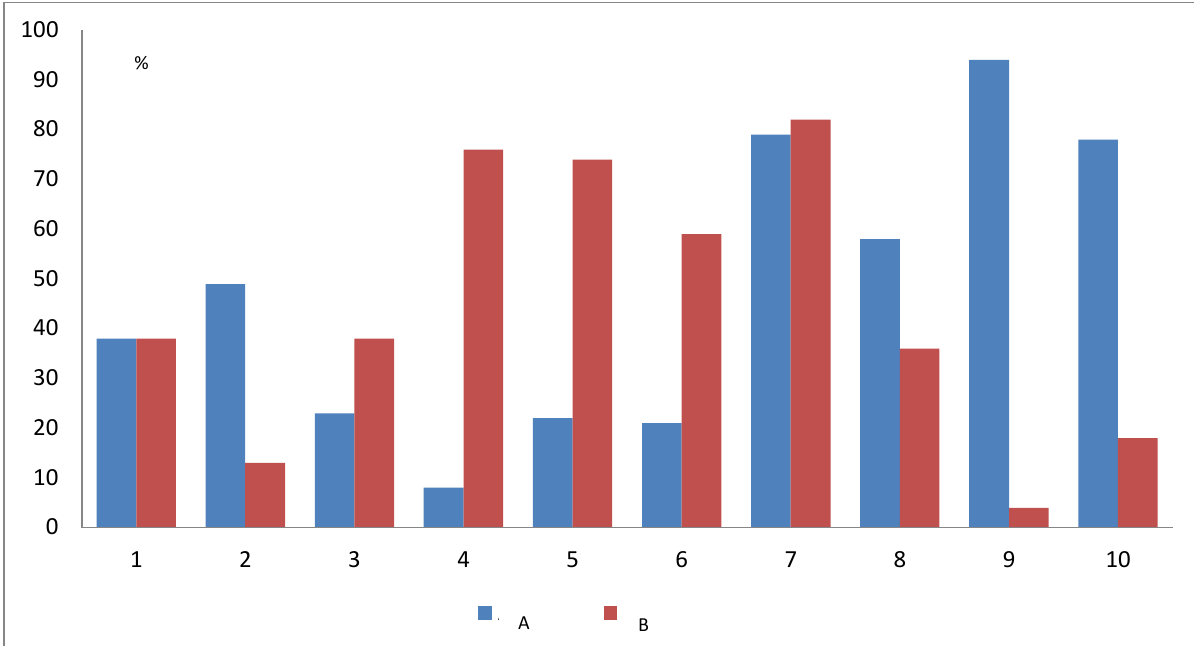
Fig.3. Time, spent by respondents for different kinds of activity: 1 – watching TV; 2 – reading; 3 –hobby; 4 – visiting of relatives; 5 – visiting of friends; 6 – cultural measures; 7 – volunteer organization and control of physical trainings; 8 – religious communities; 9 – volunteer organizations; 10 –miscellaneous.